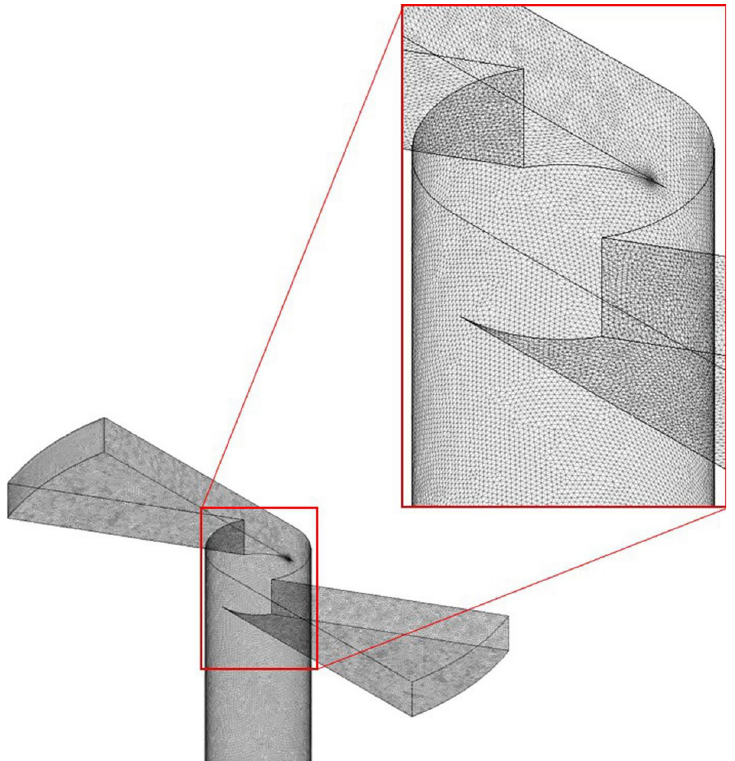
Fig 5. Computational mesh of the nebulizer